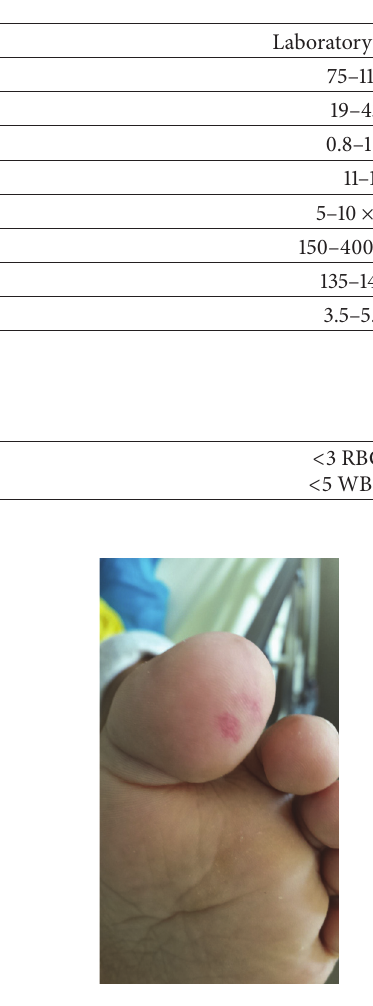
Figure 1: Janeway lesion on patient’s left